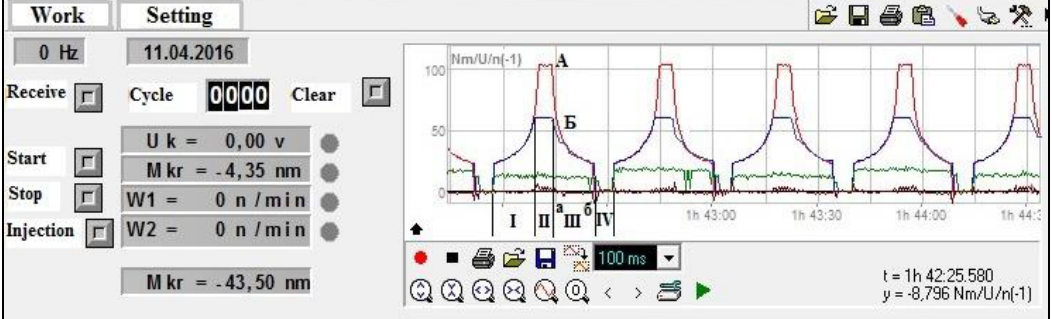
Fig. 1. Schematic representation of tribosystem operation in nonstationary conditions of friction. Areas: І - start; ІІ - stationary work; III - braking; IV -